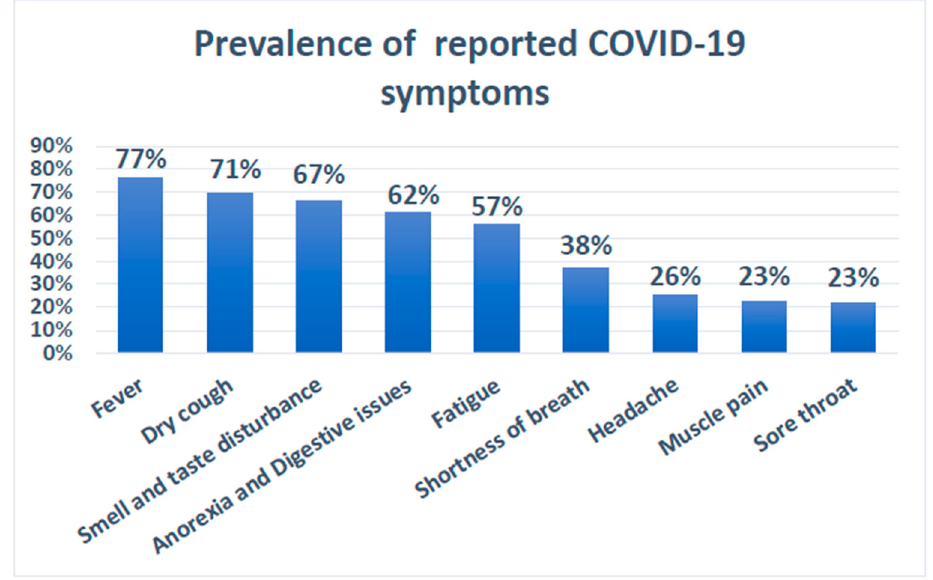
Figure 11. Prevalence of reported COVID-19 symptoms.